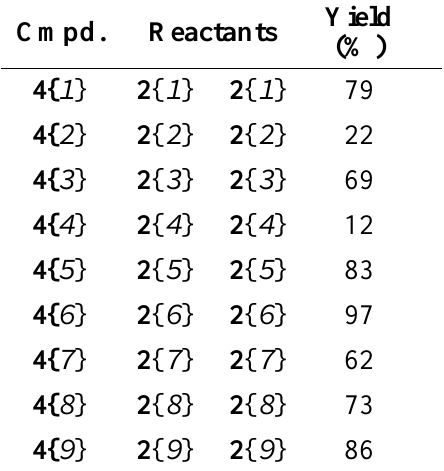
Table 2. Symmetrically-disubstituted Amino Acid Ester I45DCs, 4 { 1 - 9 }. Cmpd.